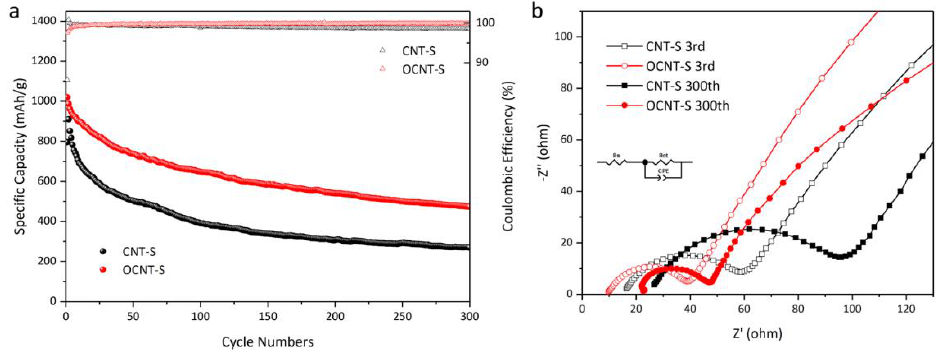
Figure 3. ( a ) Cycling performance of Li-S cells assembled with CNT-S and OCNT-S as cathodes at a current density of 0.1 C. ( b ) EIS spectra of the CNT-S and OCNT-S after 3 cycles and after 300 cycles.